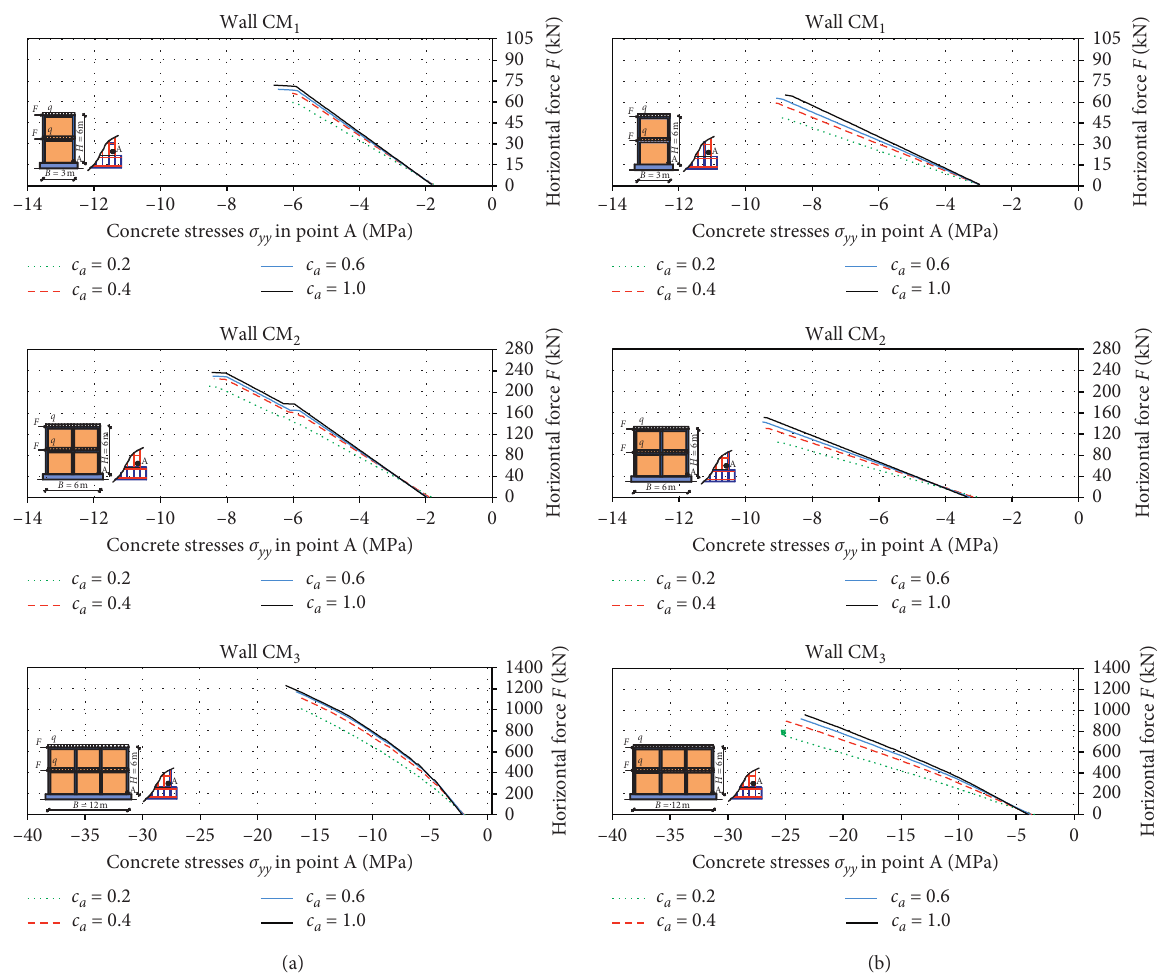
Figure 14: Vertical stresses in concrete in point A at the bottom of confined masonry walls: (a) stiff masonry; (b) soft